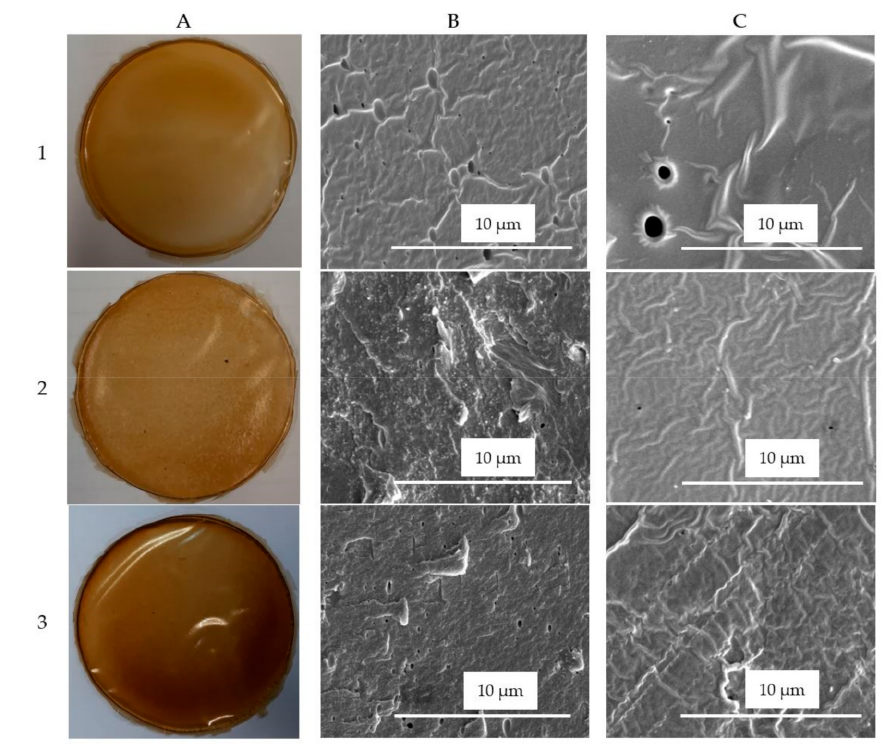
Figure 8. Images of hemp protein films ( A ), and of their SEM cross-sections ( B , magnification 8000 × ) and surfaces ( C , magnification 8000 × ), containing 50% glycerol and prepared in the absence (1) and presence of either 6% egagropili nanocristalline cellulose (2) or lignin fraction (3). Further experimental details are given in the